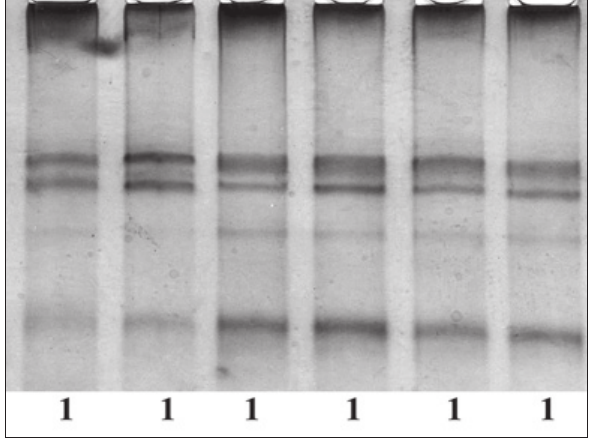
Polymerase chain reaction-single-strand conformation polymorphism patterns of Fragment II of heat shock protein 70 gene.